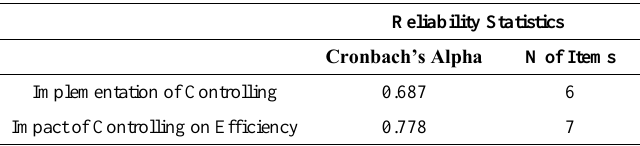
Table 5. The reliability and validity of the results